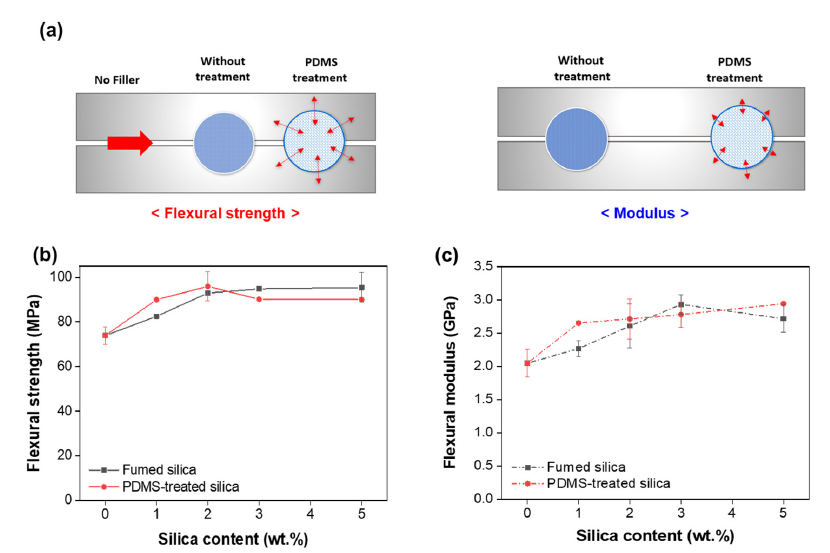
Figure 6. ( a ) Illustration of mechanical properties. Variations in the ( b ) flexural strength and ( c ) flex- ural modulus of the epoxy/fumed silica composites as functions of silica content. ( c ) flexural modulus of the epoxy/fumed silica composites as functions of silica